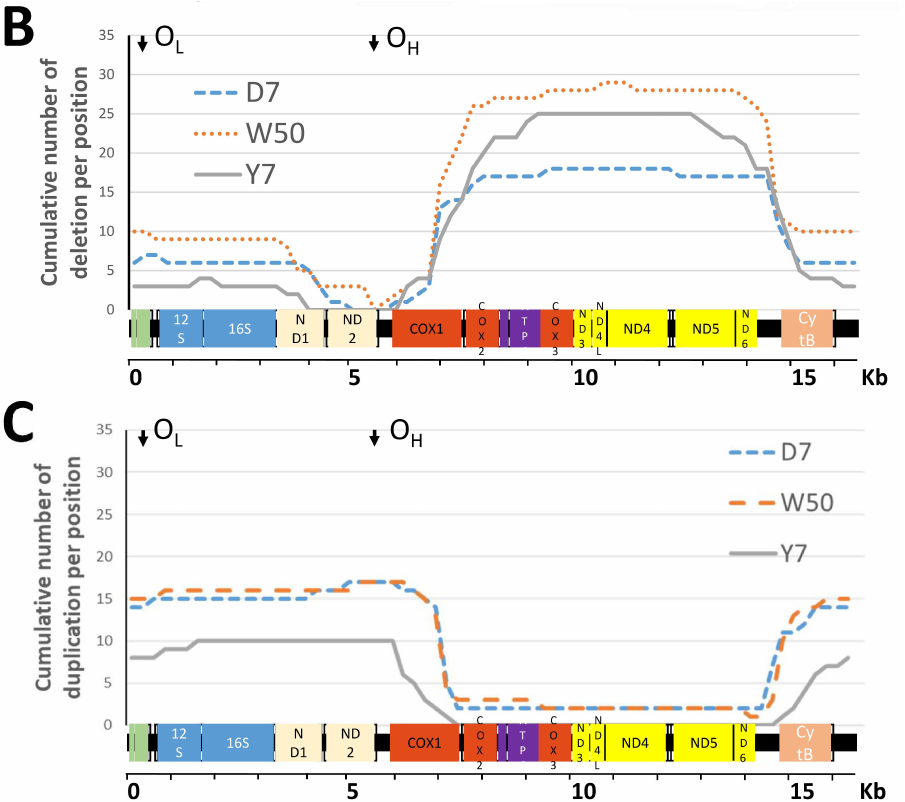
Figure 1. mtDNA deletions among HEU children. Subfigure A shows schematic representation of the eKlipse high-throughput computational pipeline result. Three mitocircles are shown per child at the three time points. The outer circle represents the mtDNA genome. Deletions are visualized in the center of the circles as red lines and duplication as blue lines. More intense is the color of the line, and higher is the heteroplasmy. The inner circle contains data related to the sequencing coverage. Higher is the thickness of the grey, higher is the number of read per position. Subfigure B and C : mapping of the mtDNA alterations among HEU. The cumulative number of deletions ( B ) or duplication ( C ) per position was plotted against a linear mitochondrial genome. Each line represents the three time